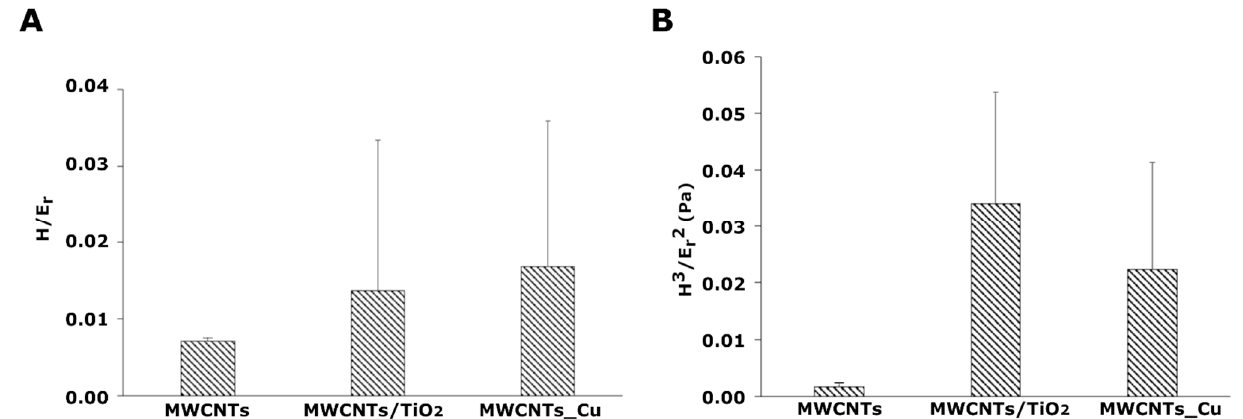
Figure 7. The diagrams for the H/E r ( A ) and the H 3 /E r2 parameter ( B ), calculated for the MWCNTs, MWCNTs/TiO 2 bi-layer, and the MWCNTs_Cu dispersion coating, examined under indentation load of 10 mN.